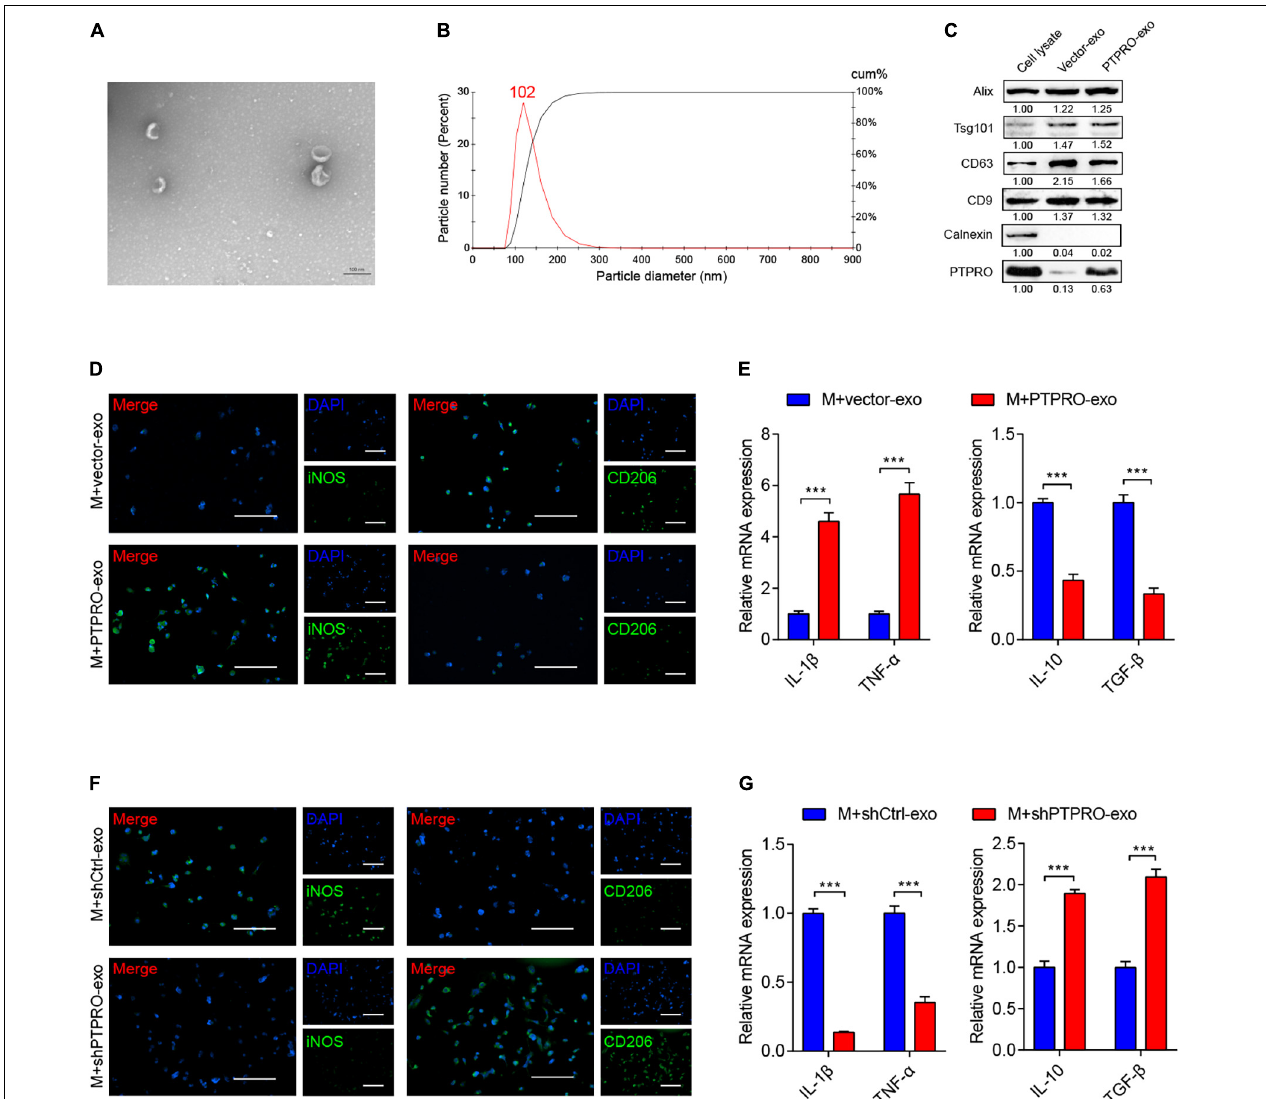
FIGURE 3 | Tumor cell-derived PTPRO inflected macrophage polarization via exosome carrier. (A) Electron microscopy images of exosomes isolated from ZR-75-1-PTPRO cells. (B) Nanoparticle tracking analysis (NTA) of exosomes isolated from ZR-75-1-PTPRO cells. (C) The expressions of Alix, TSG101, CD63, CD9, Calnexin, and PTPRO were measured by immunoblotting in exosomes isolated from ZR-75-1-PTPRO cells. Relative protein expression was quantified. (D) Representative images of immunofluorescence staining of iNOS and CD206 in THP1-derived macrophages after treating with ZR-75-1-vector-exo or ZR-75-1-PTPRO-exo for 48 h. Scale bars = 50 µ m. (E) qRT-PCR was applied to detect the relative expression of IL-1 β , TNF- α , IL-10, and TGF- β in THP-1 derived macrophage after treating with ZR-75-1-vector-exo or ZR-75-1-PTPRO-exo for 48 h. (F) Representative images of immunofluorescence staining of iNOS and CD206 in THP1-derived macrophages after treating with ZR-75-1-shCtrl-exo or ZR-75-1-shPTPRO-exo for 48 h. Scale bars = 50 µ m. (G) qRT-PCR was applied to detect the relative expression of IL-1 β , TNF- α , IL-10, and TGF- β in THP-1 derived macrophage after treating with ZR-75-1-shCtrl-exo or ZR-75-1-shPTPRO-exo for 48 h. Error bars, SEM. *** P < 0.001 by Student’s t